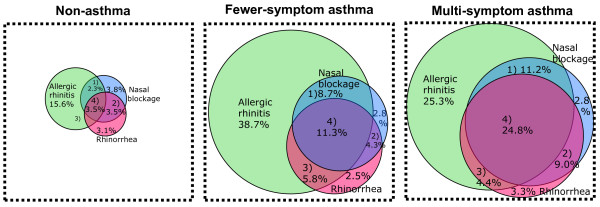
Venn diagram describing the frequency of reported allergic rhinitis, nasal blockage and/or rhinorrhea in the non-asthma, fewer-symptom asthma and multi-symptom asthma groups. The diagram illustrates that more subjects in the multi-symptom asthma group have multiple nasal symptoms.